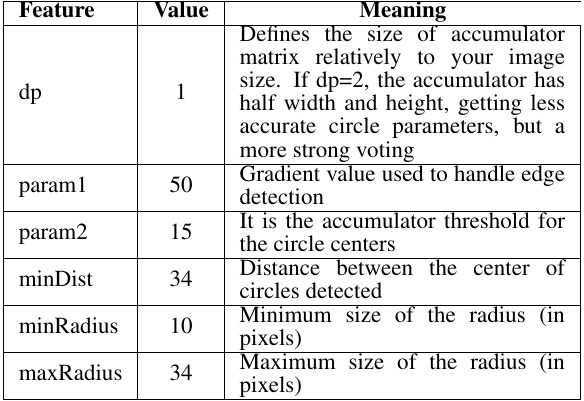
Table 1. Parameters adjusted to CHT 4